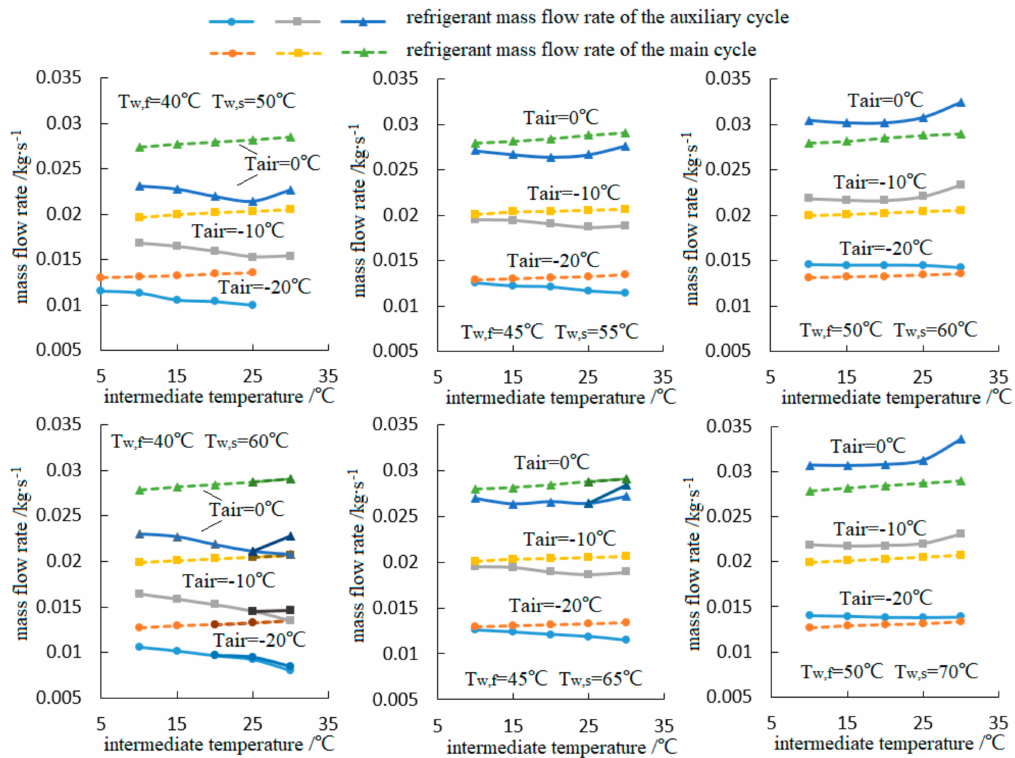
Figure 7. The refrigerant mass flow rates in both auxiliary and main cycles versus the intermediate